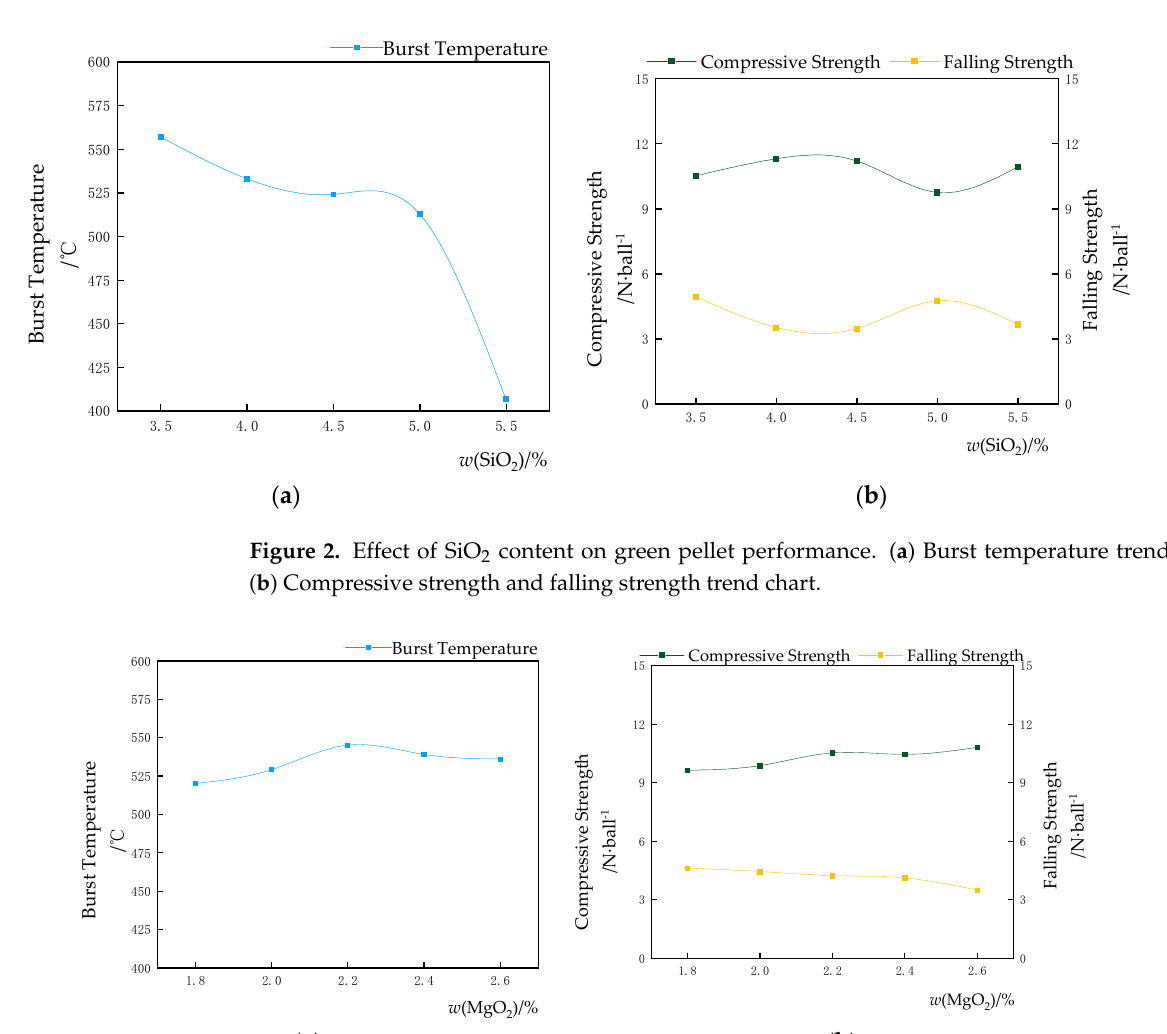
Figure 2. Effect of SiO 2 content on green pellet performance. ( a ) Burst temperature trend chart, ( b ) Compressive strength and falling strength trend chart.